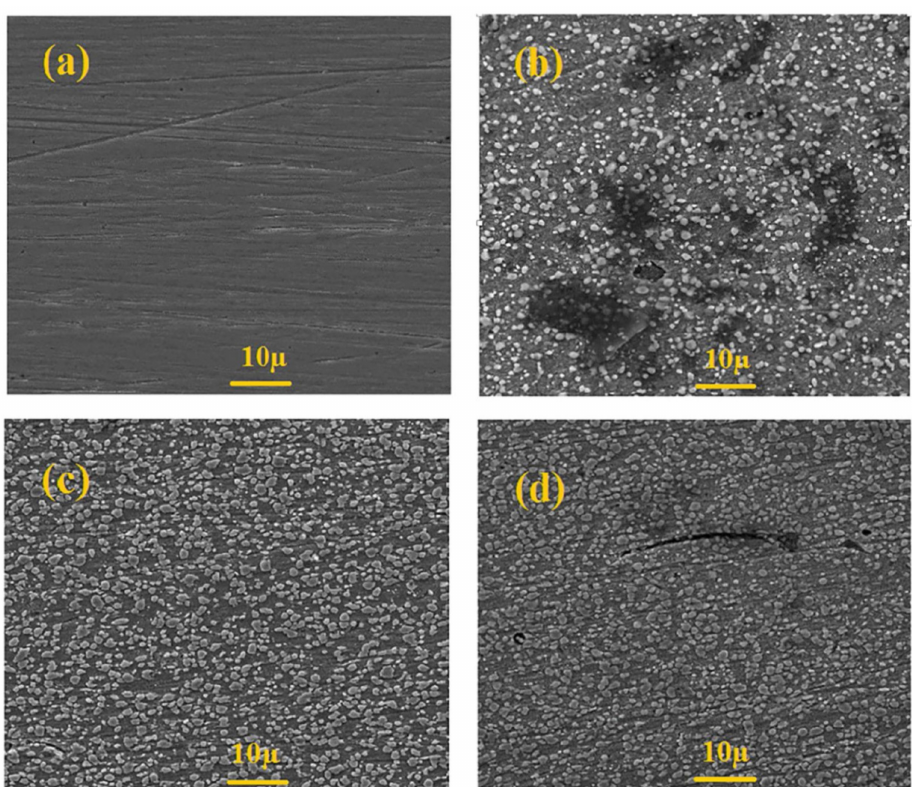
Figure 8. SEM image of mild steel surface, ( a ) freshly polished mild steel surface, ( b ) mild steel surface after 4 h of soaking in 1.0 M HCl, ( c , d ) mild steel surface after 4 h of soaking in 1.0 M HCl in the presence of 5 mM L-cysteine and D-penicillamine, respectively. (Reprinted with permission from Ref. [139]. Copyright 2020 Elsevier